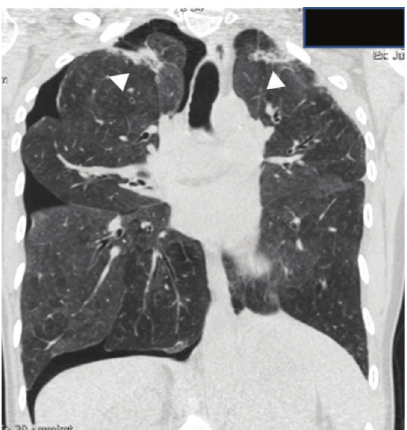
Figure 6: Case 2. Coronal HRCT reformatted image shows a right pneumothorax and the presence of fibrotic pulmonary infiltrates in both apical regions (arrowheads).